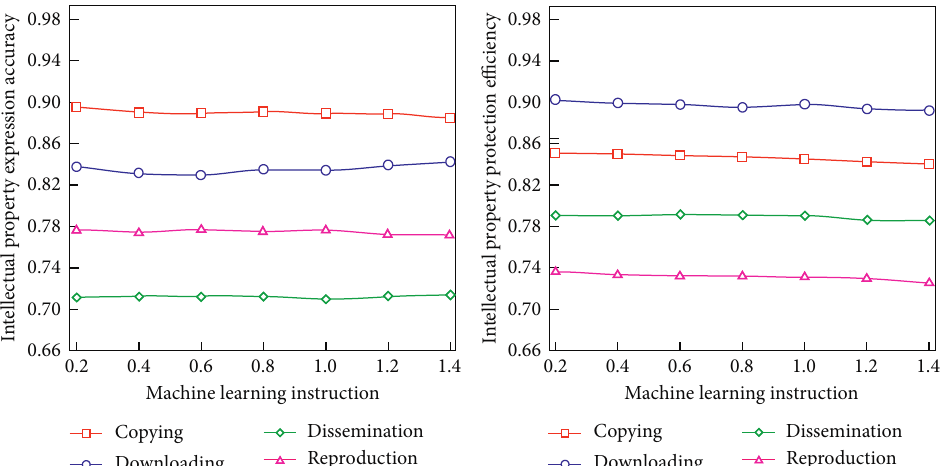
Figure 7: Intellectual property expression accuracy and protection efficiency of educational resource data in the processes of copying, downloading, reproduction, and